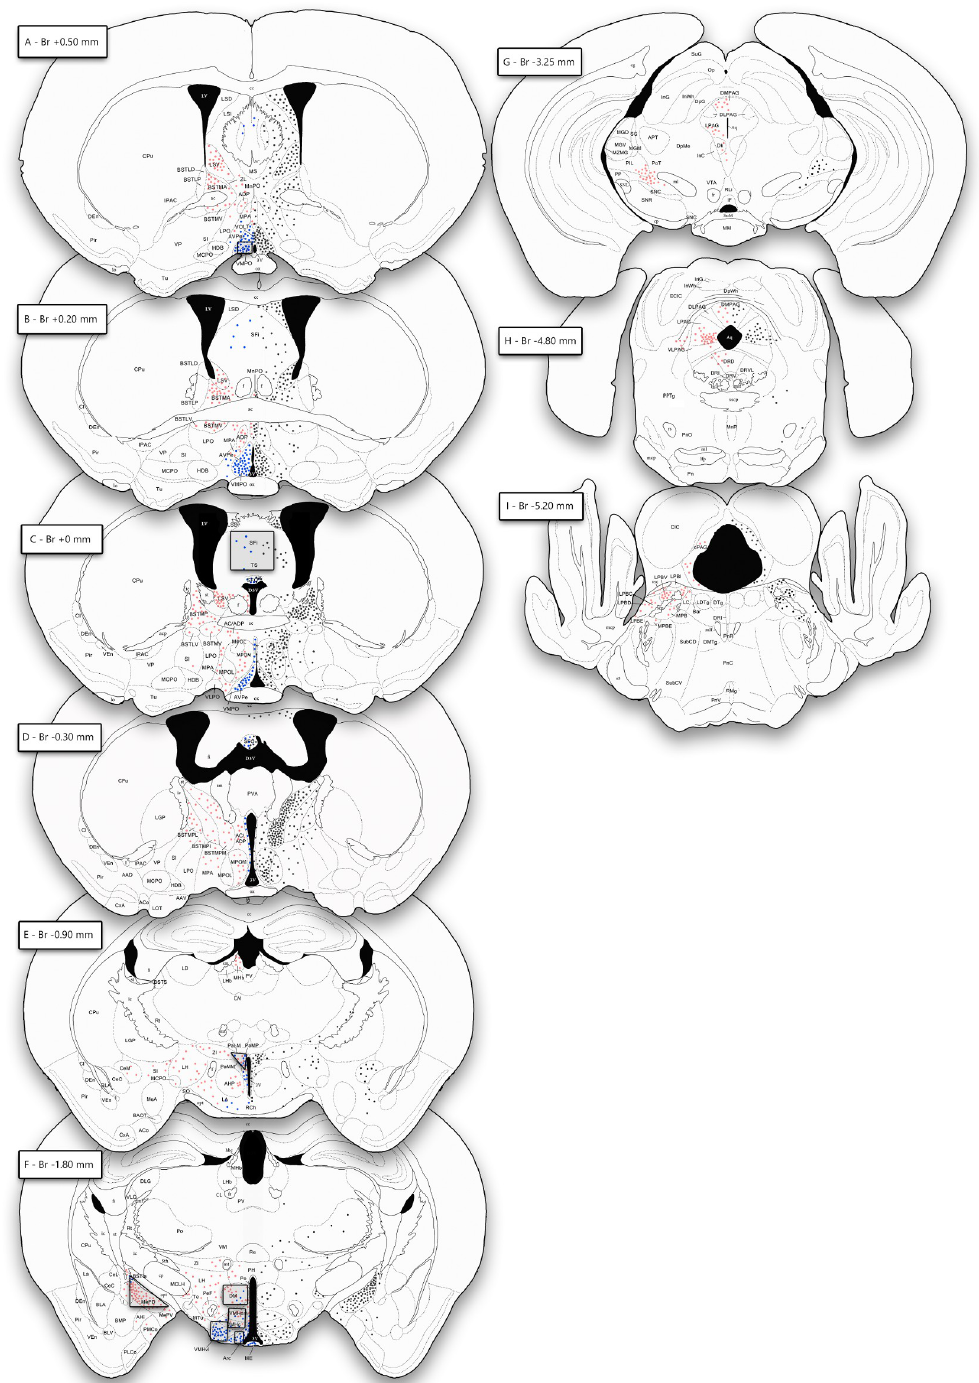
Fig 1. Mapping of pSTAT5 immunoreactivity and prolactin receptor expression in the brains of male and female mice. Semi-schematic camera lucida drawings of coronal sections of the mouse brain showing the distribution patterns of pSTAT5-ir in female and male mice (left side) and the pattern of PRLR expression in the brain of an adult male mouse specimen (right side), as determined by PRLR expression data obtained from the Allen Brain Institute (2004 Allen Institute for Brain Science. Allen Mouse Brain Atlas. Available from: mouse.brain-map.org experiment 72340223, http://mouse. brain-map.org/experiment/show/72340223). In the left side, pink dots represent pSTAT5 expression exclusive of ovariectomized, steroid-primed females, whereas dark blue dots encode overlapping expression of pSTAT5-ir in both the